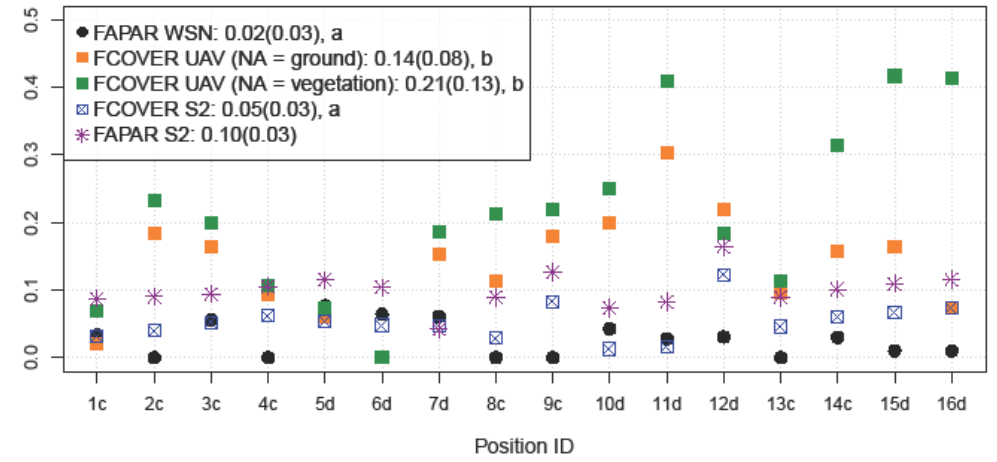
Figure 10. Difference between the summer and spring values of FAPAR and FCOVER products at individual sensor locations of the WSN. The legend gives the mean (sd), and the results of the KS test are indicated with small letters ( p > 0.05). Position IDs ( x -axis) of PAR sensor locations indicate species compositions in the 10-m surroundings as follows: c = ratio of basal area of conifers ≥ 85% and d = ratio of basal area of conifers <85%.